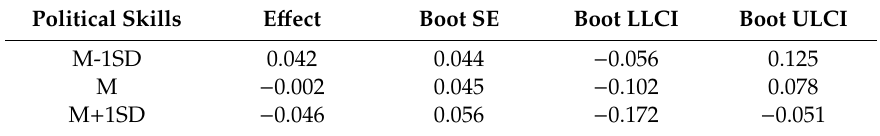
Table 10. The results of moderated